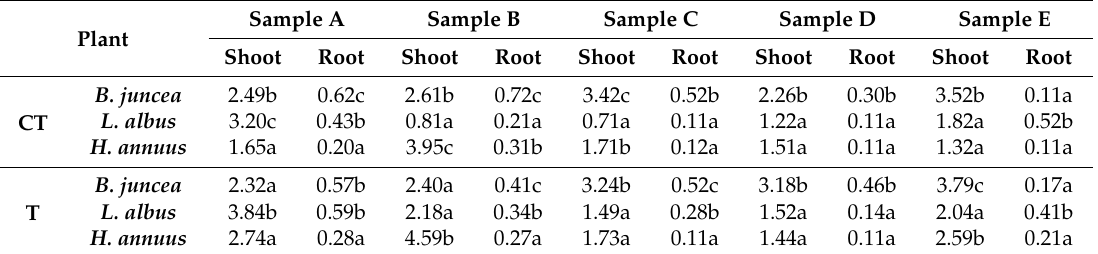
Table 1. Dry biomass yield (g · pot − 1 ) of B. juncea , L. albus and H. annuus , untreated (CT) and treated (T), grown in contaminated soils with different As